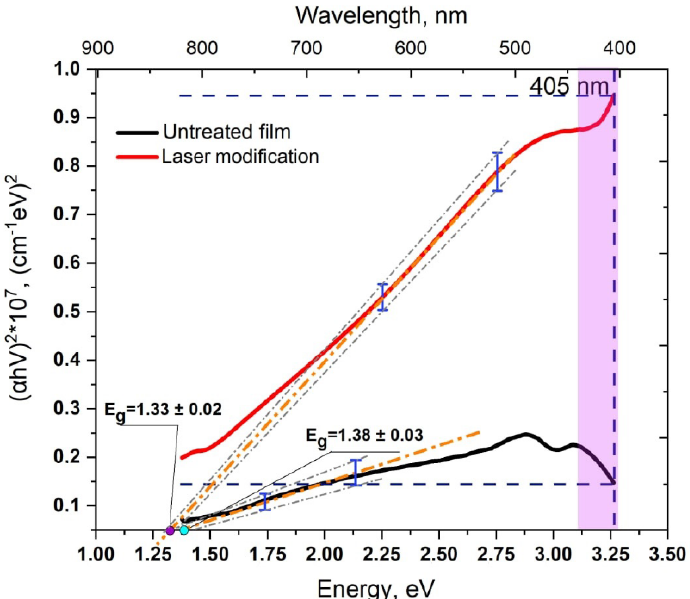
Figure 8. Optical band gap E g graphical determination (orange line) for PbSe films various treatments: untreated (black curve), laser modification (red curve).